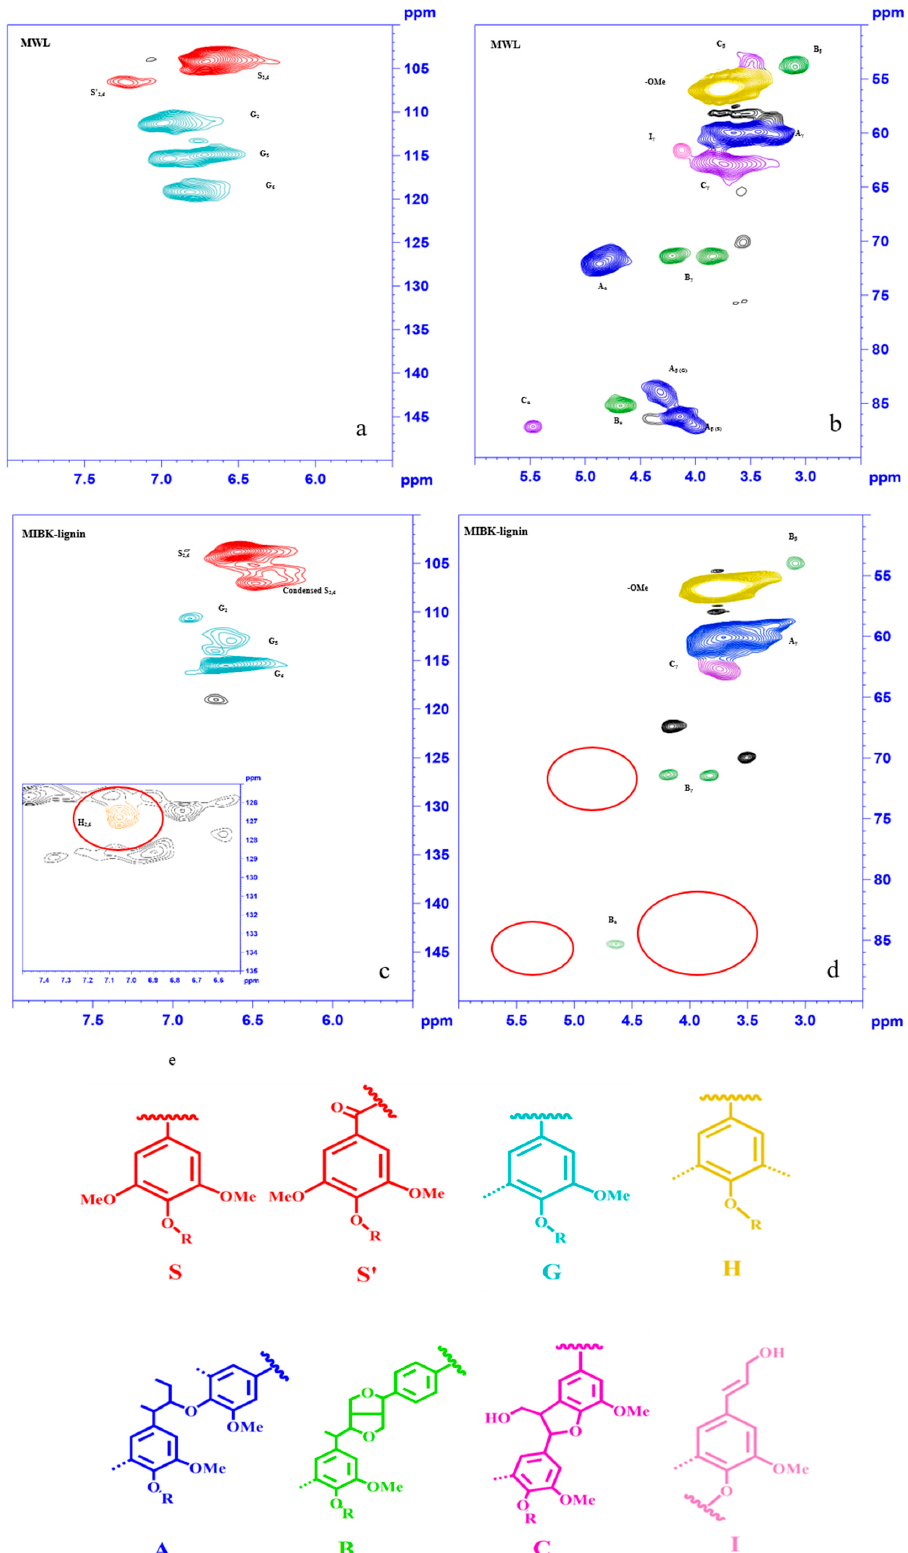
Figure 3. 2D HSQC NMR spectra of MWL and MIBK-lignin. ( a ) the cross-peaks from aromatic ring region of MWL ( b ) the cross-peaks from side-chain region of MWL ( c ) the cross-peaks from aromatic ring region of MIBK-lignin ( d ) the cross-peaks from side-chain region of MIBK-lignin ( e ) the chemical structures of lignin units.